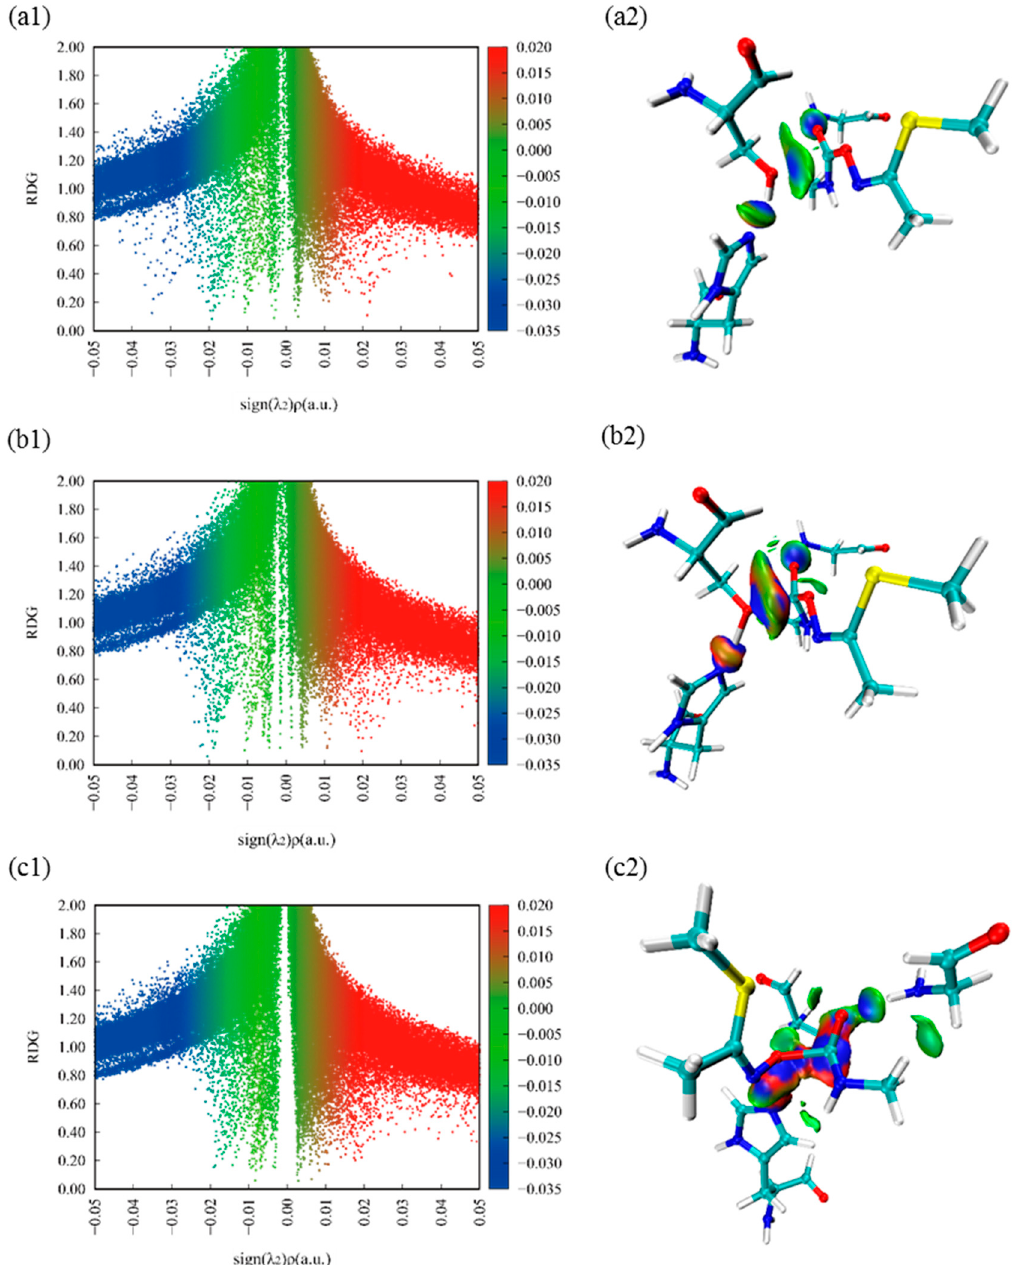
Figure 4. Color-mapped reduced density gradient (RDG) iso-surface graphs and scatter plots of methomyl and three critical amino acids. Species shown: ( a1 ), ( b1 ), ( c1 ) show the color-mapped reduced density gradient (RDG) scatter plots of methomyl and three critical amino acids of R, TS1, TS2, respectively. ( a2 ), ( b2 ), ( c2 ) show the color-mapped reduced density gradient (RDG) iso-surface graphs of methomyl and three critical amino acids of R, TS1, TS2, respectively.